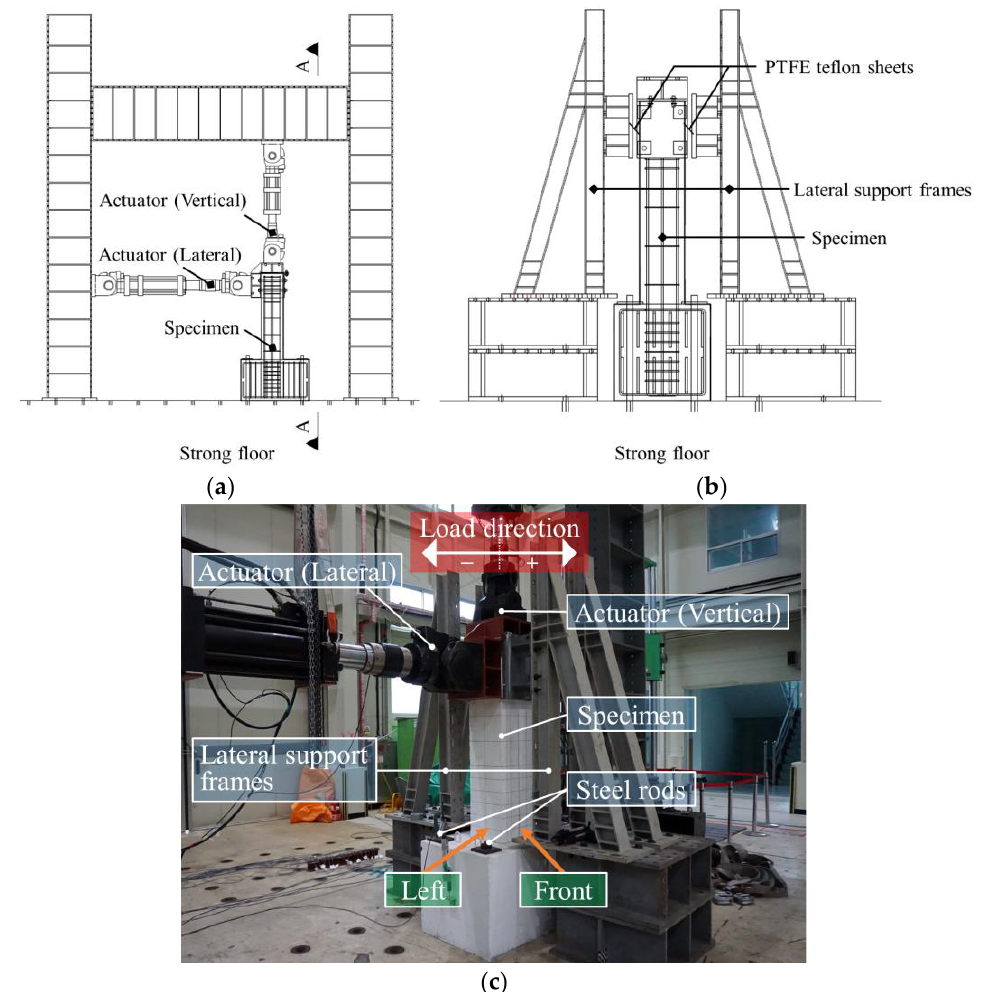
Figure 2. Test setup for applying vertical and horizontal loads to RC columns: ( a ) Front view; ( b ) Side view (section A-A); ( c ) Photograph.